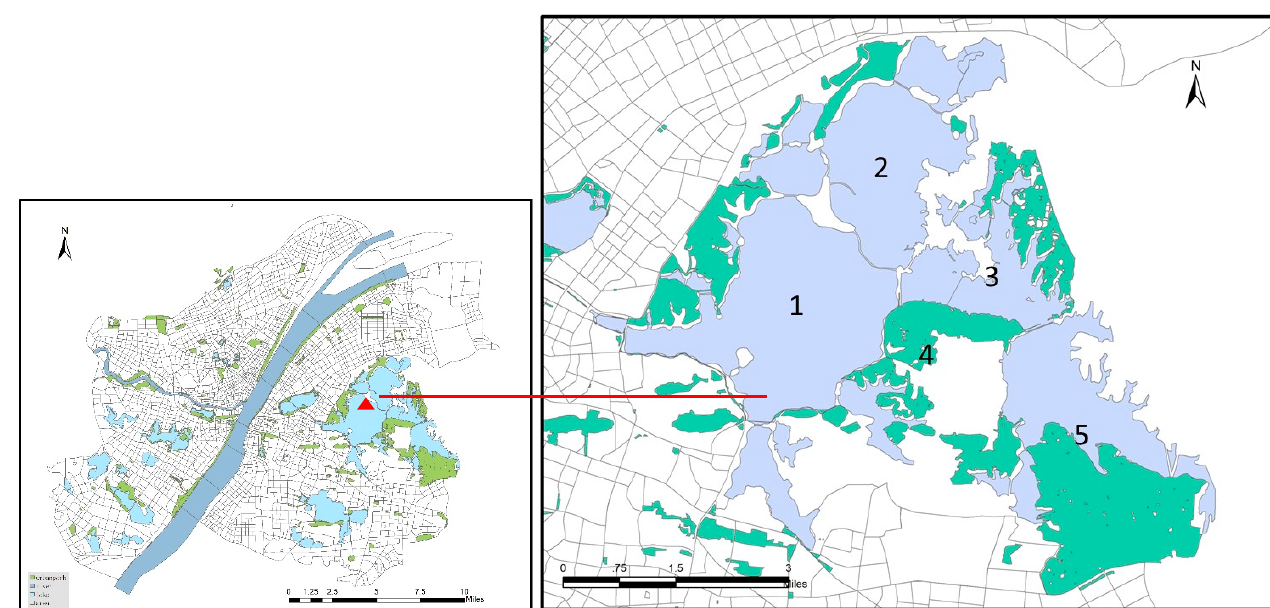
Figure 1. Scenic spot distribution map. (1 Tingtao scenic area; 2 Baima scenic area; 3 Luoyan scenic area; 4 Moshan scenic area; 5 Chuidi scenic area ).